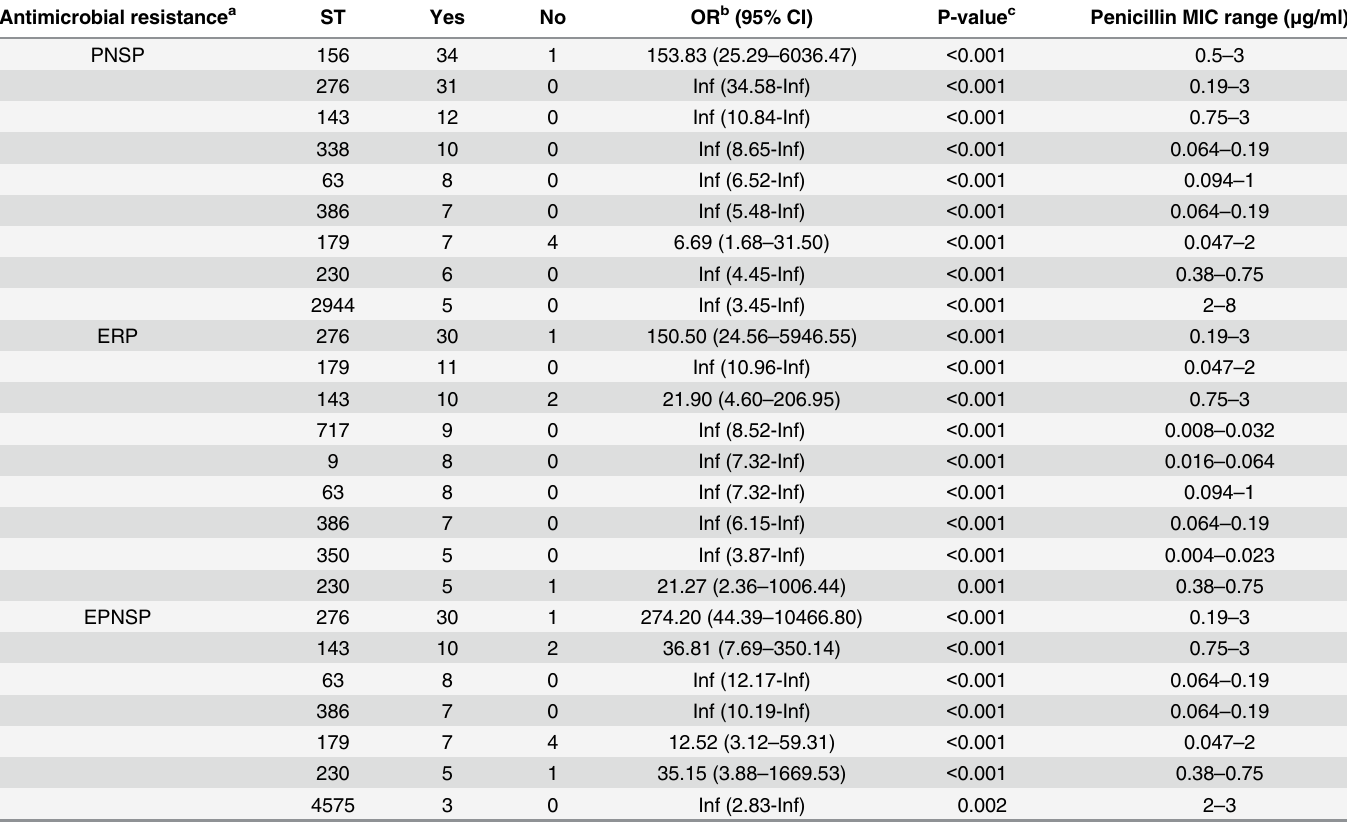
Table 4. Sequence types that were positively associated with penicillin non-susceptibility, erythromycin resistance, erythromycin and penicillin non-susceptibility simultaneously and multi drug resistance. Antimicrobial resistance